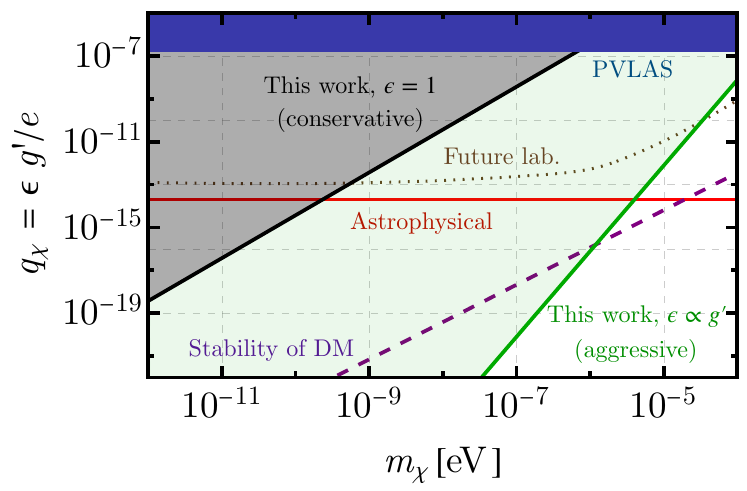
Figure 2 . Parameter space of millicharged particles (MCPs) of mass m χ and charge q χ in units of the electron charge. New particles in the blue region are ruled out by the PVLAS experiment [47, 48]. MCPs in the black-shaded region, from eq. (2.11), would violate the Festina-Lente bound, as they make black holes evaporate to pathological spacetimes in dS (see figure 1). They are thus “in the Swampland”, and theoretically disallowed. The region above the green line, given by eq. (2.13) is disfavored when further assuming that the kinetic mixing is (cid:15) = e g 0 / (16 π 2 ) , rather than just (cid:15) ≤ 1 . The area above the red line is constrained by astrophysical observations of the tip of the red giant branch [49] (though this can be circumvented [37]), whereas above the purple dashed line there are limits related to its stability as DM [50]. The dotted brown line is the forecasted sensitivity of a future laboratory experiment proposed in ref.